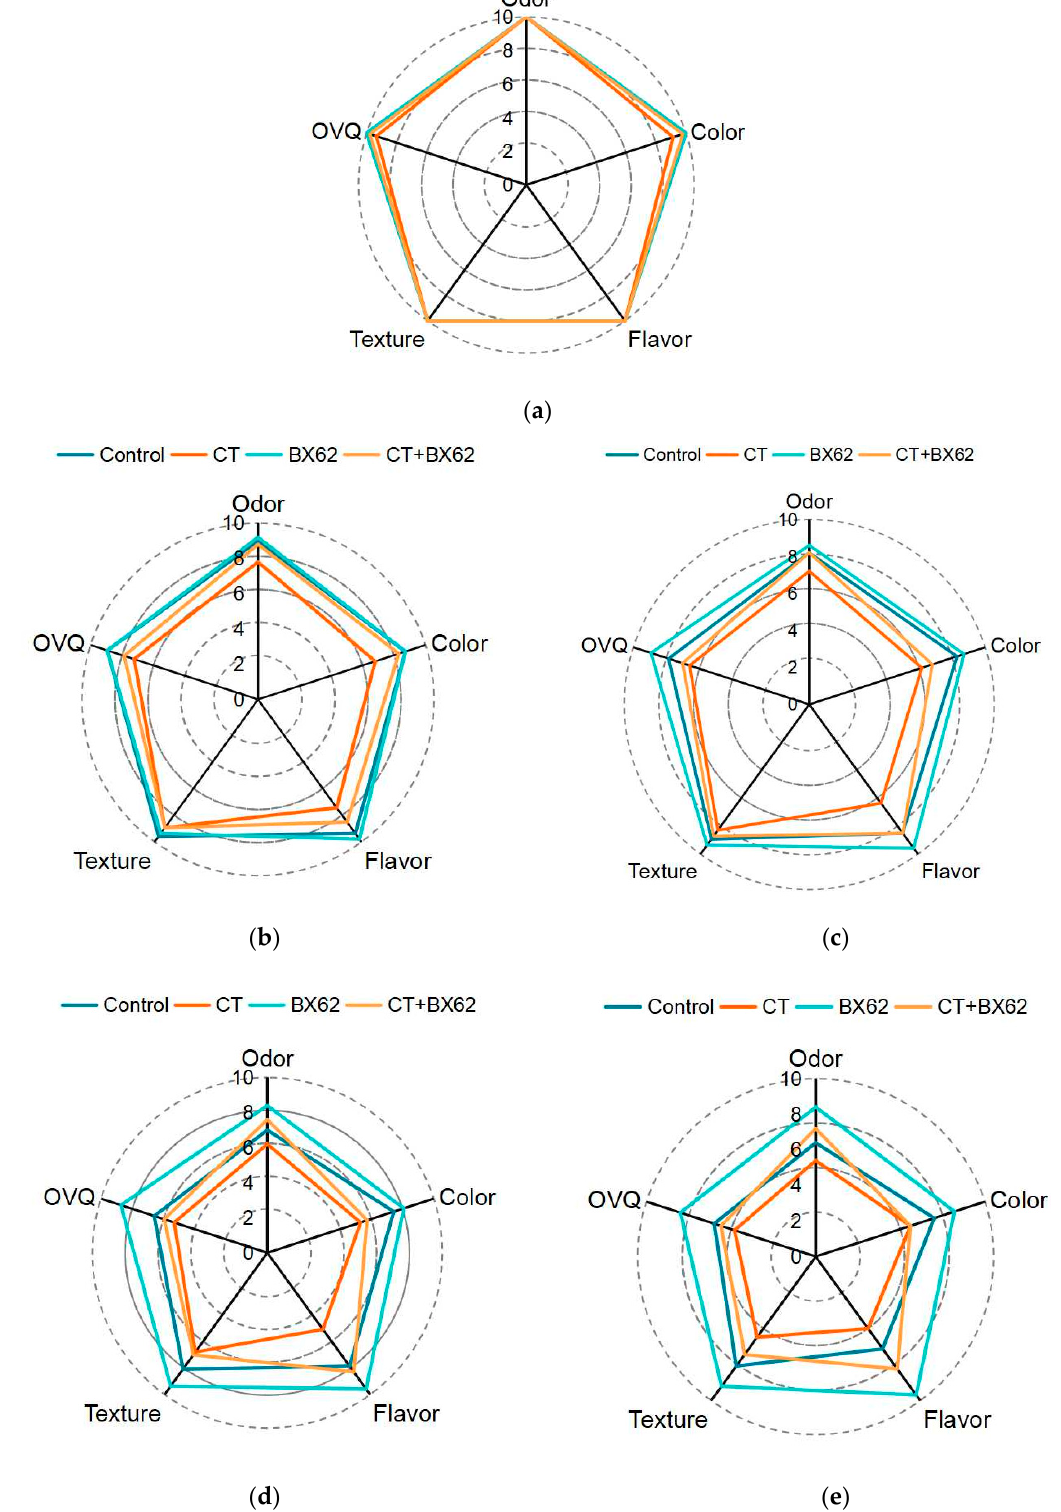
Figure 7. Sensory characteristics of fresh-cut apples treated with L. plantarum BX62 alone or incorporated with chitosan on days 0 ( a ), 2 ( b ), 4 ( c ), 6 ( d ), 8 ( e ).